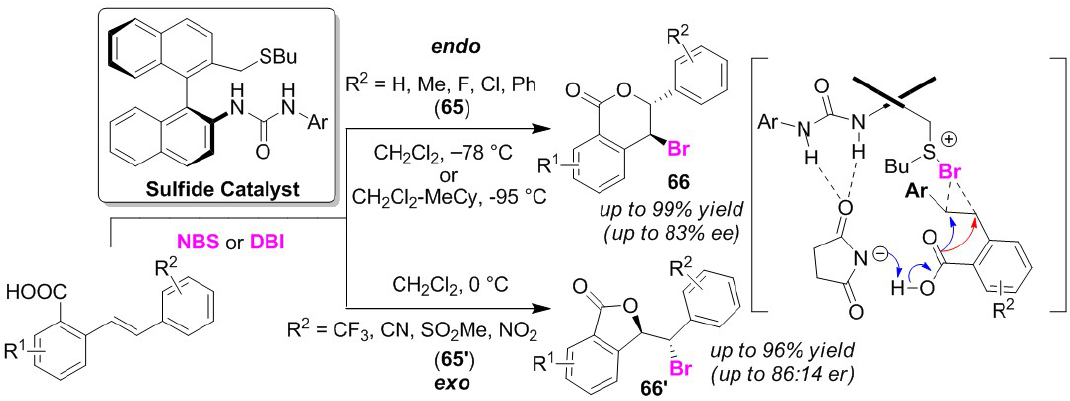
Figure 32. Endo / exo selective bromo-lactonizations of stilbene-type carboxylic acids ( 65 and 65 (cid:48) ) using a chiral sulfide